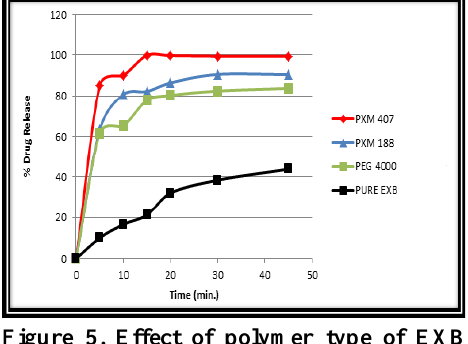
Figure 5. Effect of polymer type of EXB- solid